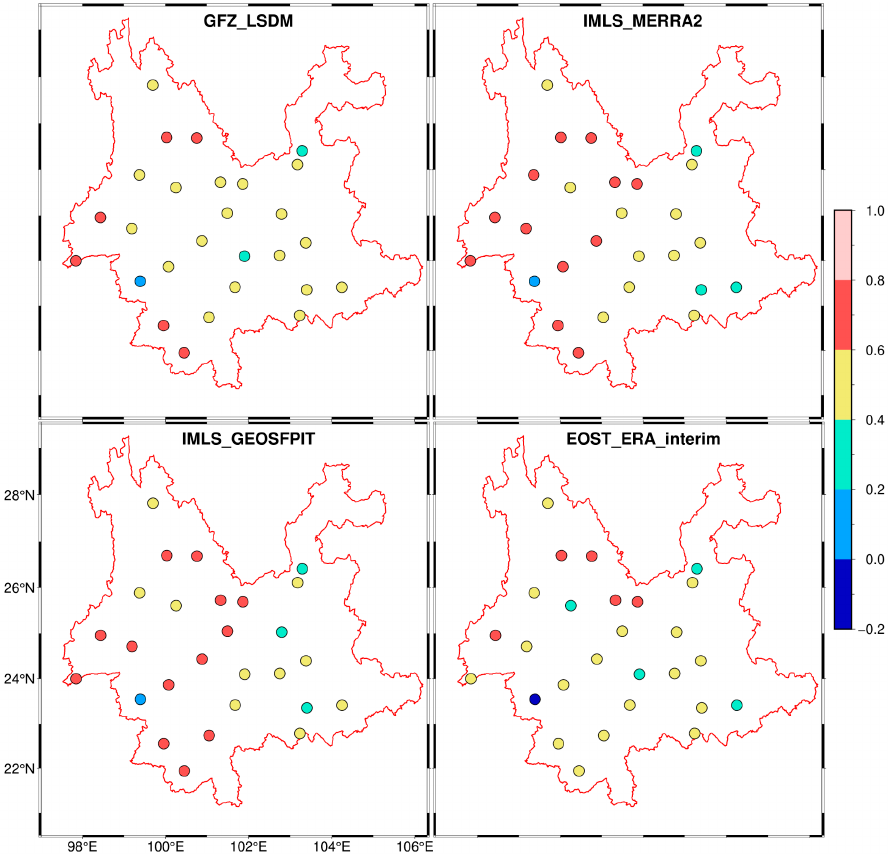
Figure 4. The correlation between four HYDL products and vertical GPS time series at 27 GPS stations.